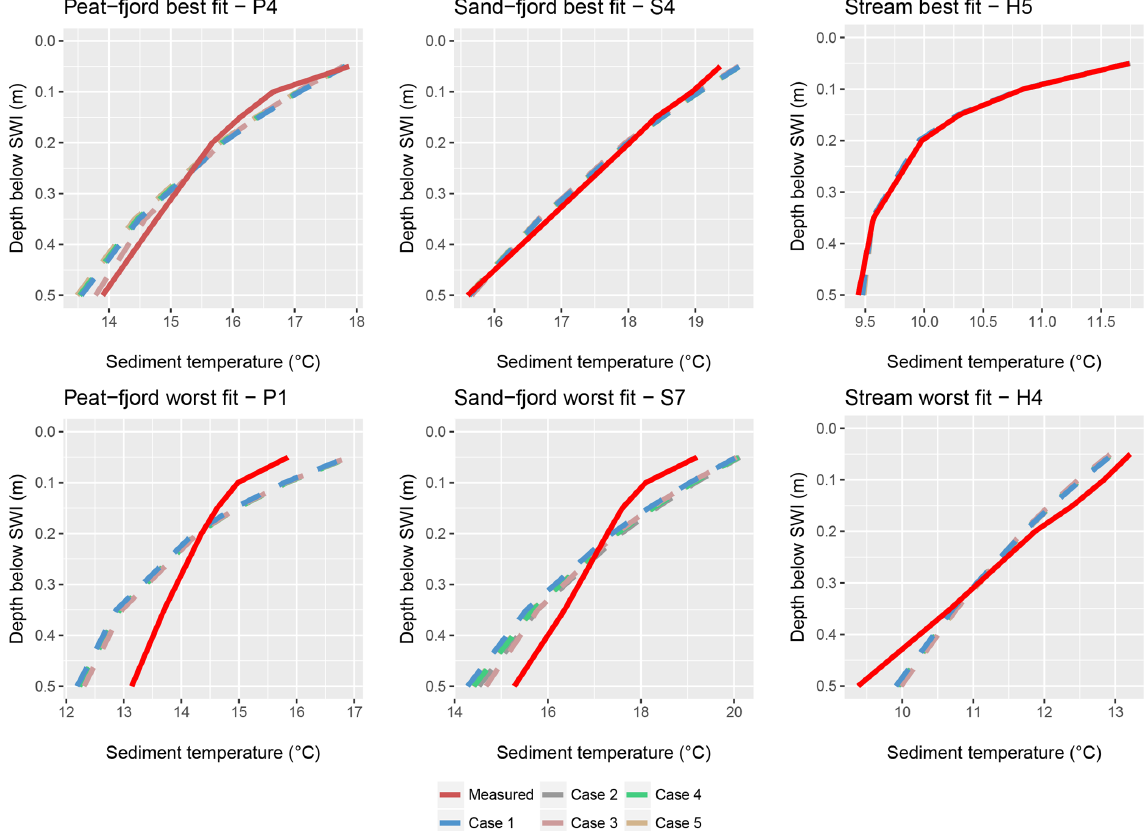
Figure 3. Best and worst fits between measured and simulated temperature values at the field sites.